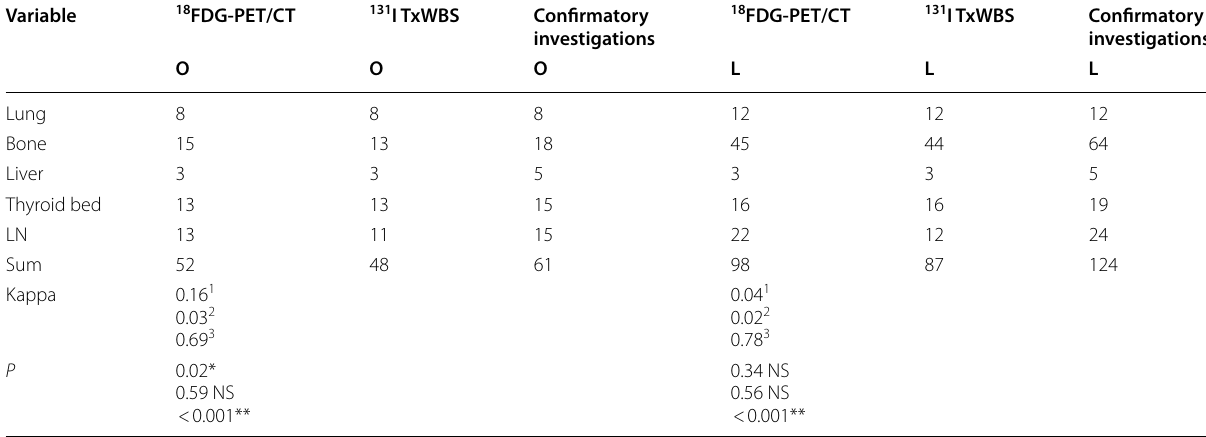
Table 3 Organ- and lesion-based analysis by 18 FDG-PET/CT and 131 I TxWBS in the context of histopathology, conventional radiological tools and lesion behavior over